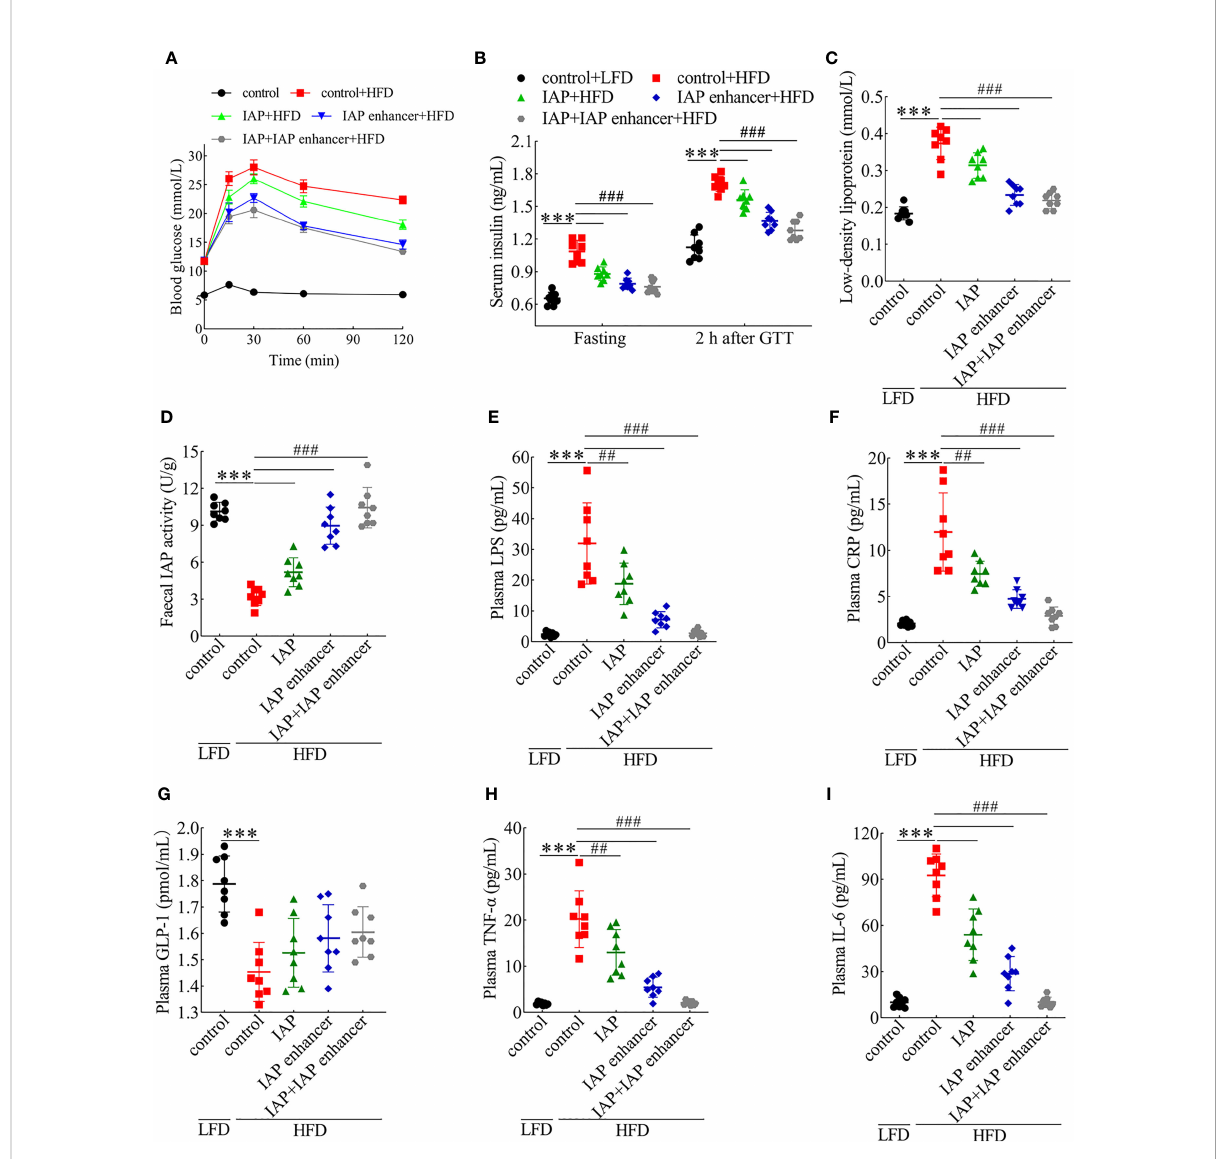
FIGURE 2 Preventive effects of IAP + IAP enhancer on HFD-induced glucose intolerance and IR. (A) Oral glucose tolerance. (B) Fasting and postprandial insulin. (C) Low-density lipoprotein. (D) Faecal IAP. (E) Plasma LPS. (F) Plasma CRP. (G) Plasma GLP-1. (H) Plasma TNF- a . (I) Plasma IL-6. Values are presented as means ± SD (n = 8/group). Two-tailed unpaired Student ’ s t test. HF control groups compared with the LF control groups, ***P < 0.001; HF treatment groups compared with the HF control groups, ## P < 0.01, ### P <